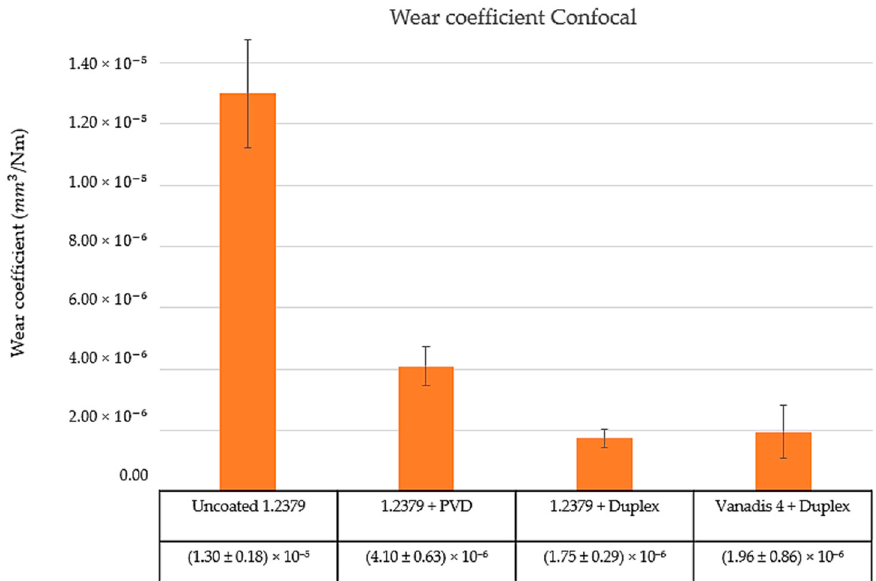
Figure 11. Comparative graph of the wear coefficient values calculated by confocal microscopy for each sample.